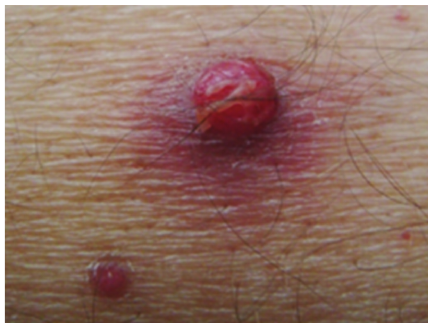
Figure 4: Mixed-cell infiltrates, predominantly granulocytes (hematoxylin-eosinstaining, 40 ×